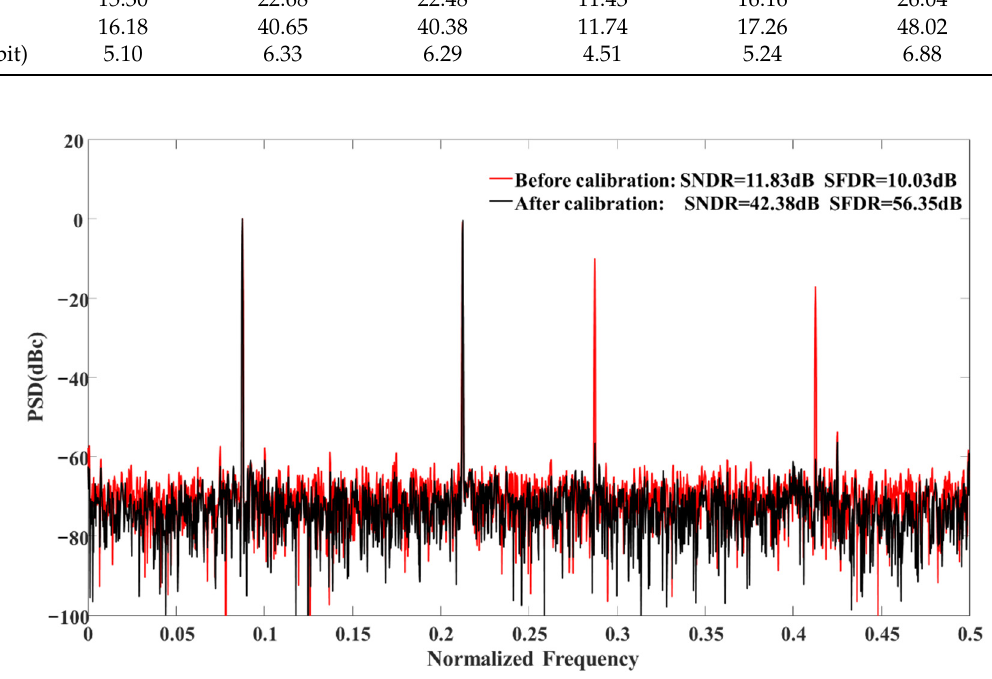
Figure 17. The frequency spectrum of the two-tone signals in the commercial 2-channel TI-ADCs before and after calibration.